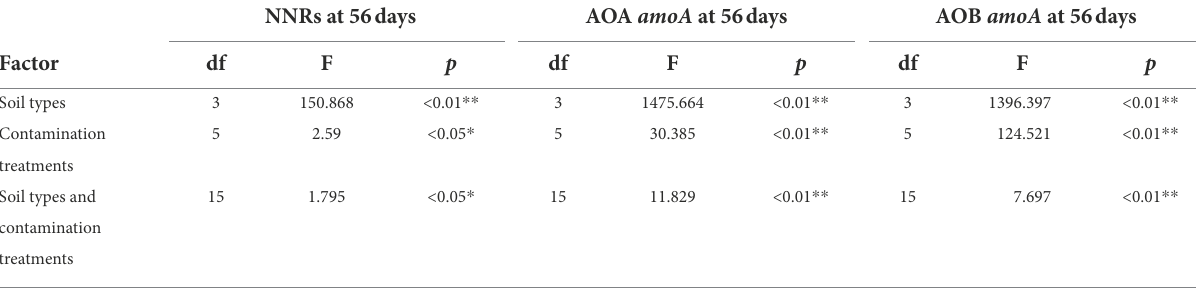
TABLE 3 Two-factor ANOVA based on soil types and pollution